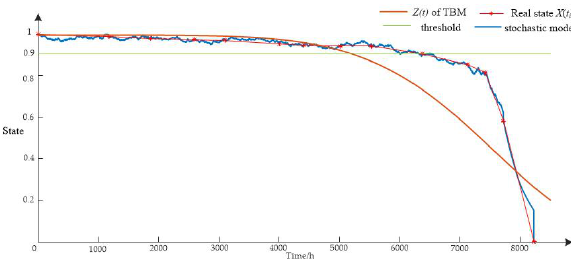
Fig. 5. Gearbox 1 state diagram under TBM and stochastic model